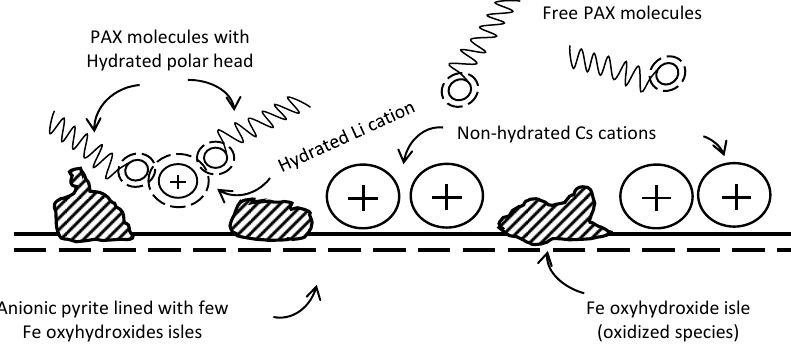
Figure 5. Schematic of cation and PAX adsorption onto pyrite at the molecular level. Low concentration of cations ( < 0.01 M) favors formation of Li-mediated pyrite–PAX bridges. At higher concentrations, the surface is so lined with cations that PAX ceases to have a role on the surface of the pyrite and, thus, on the zeta potential.